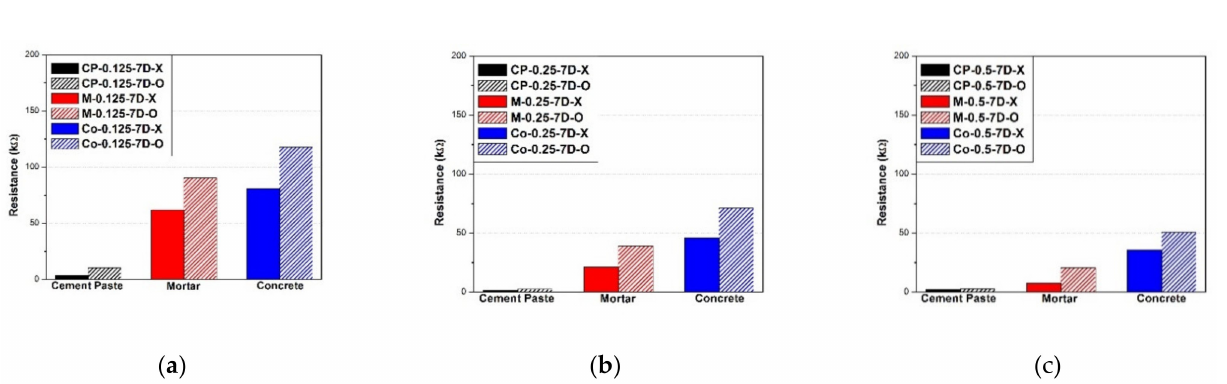
Figure 11. Electrical resistance at 7 d of curing: ( a ) 0.125 wt%, ( b ) 0.25 wt%, and ( c ) 0.5